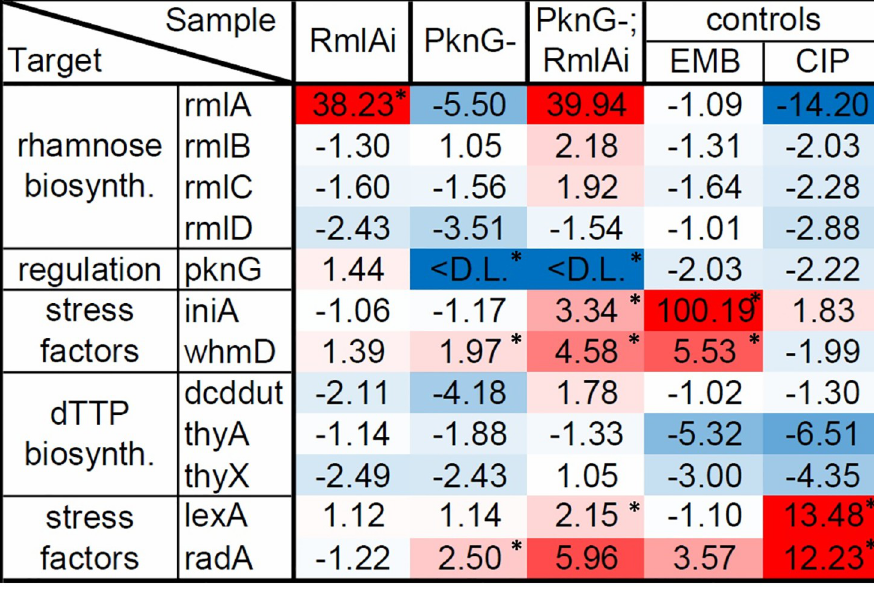
Fig 8. Effects of RmlA overexpression on the expression of different genes. RadA and LexA were used as indicators for replication stress, while IniA and WhmD indicated cell wall biosynthesis stress. Dcd:dut, ThyA, and ThyX represent the thymidylate biosynthesis pathway, while RmlA-D belongs to the rhamnose biosynthetic pathway. PknG, known to regulate rhamnose biosynthesis, was also measured. The following treatments were used as positive controls: CIP for replication stress and EMB for cell wall biosynthesis stress. Expression levels were normalized to those of the WT strain. Changes in expression levels are shown as a heat map. Blue depicts downregulation, while red is for upregulation. Black star indicates p < 0.05 for the change in